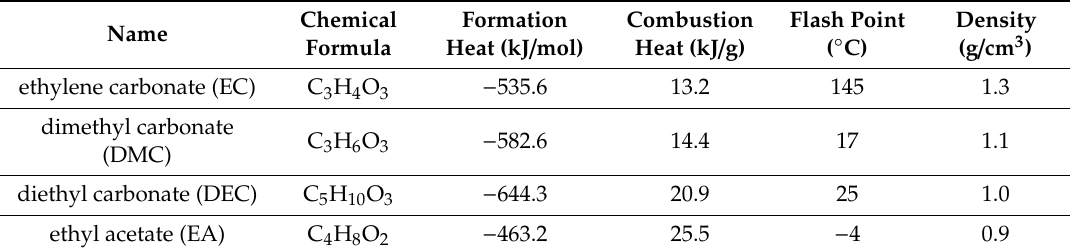
Table 1. List of carbonate and carboxylate used for electrolyte thermal safety study in this paper.